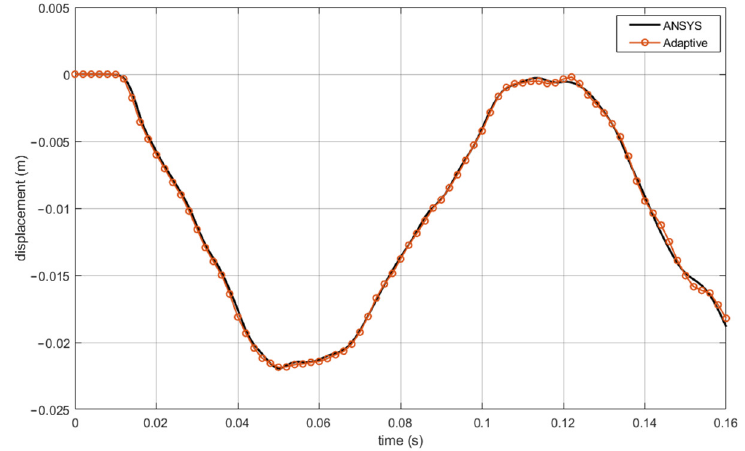
Figure 31. The transient vertical displacement at point A, ∆ t = 0.001 s and c = 1 Ns/m for the Heaviside tension step loading.